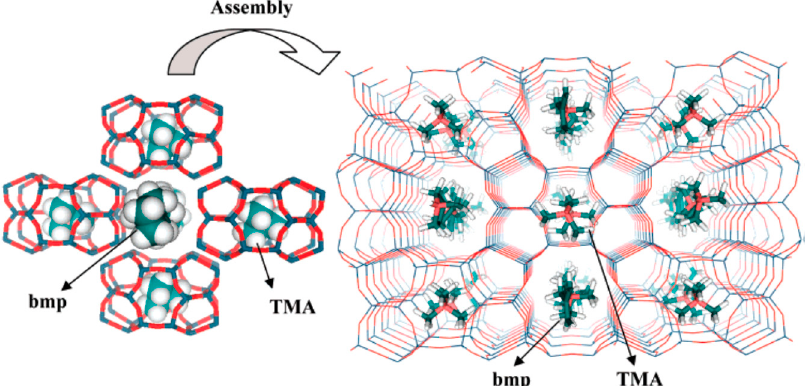
Figure 2. Schematic representation of the self-assembly of tetramethylammonium (TMA)-filled cavities around benzylmethylpyrrolidinium (BMP) molecules to give the final FER structure. Reprinted with permission from ref. [66]. Copyright 2007, American Chemical Society.